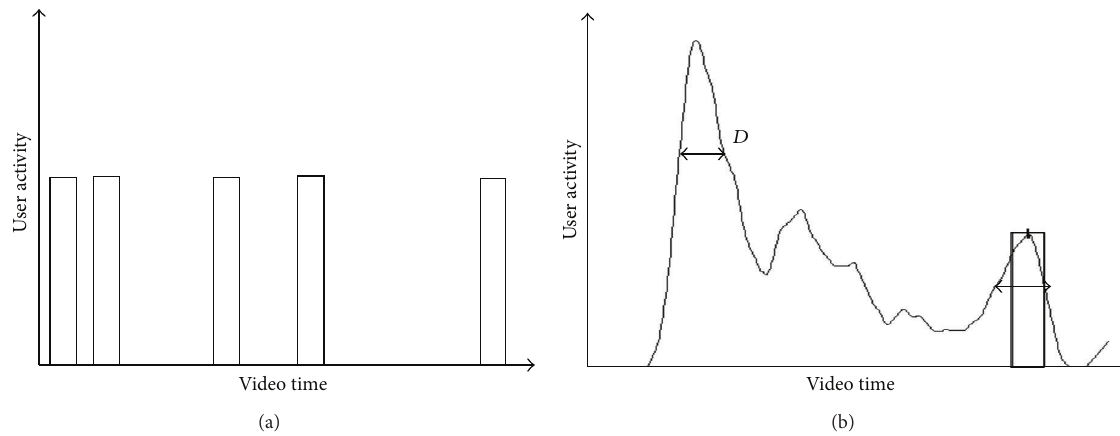
Figure 3: The pulse of reference (a), which is based on manually selected video scenes, is compared to the experimental pulse (b), which is created at the local maximum of the (smooth) user activity signal. The optimum pulse width 𝐷 is also depicted schematically.